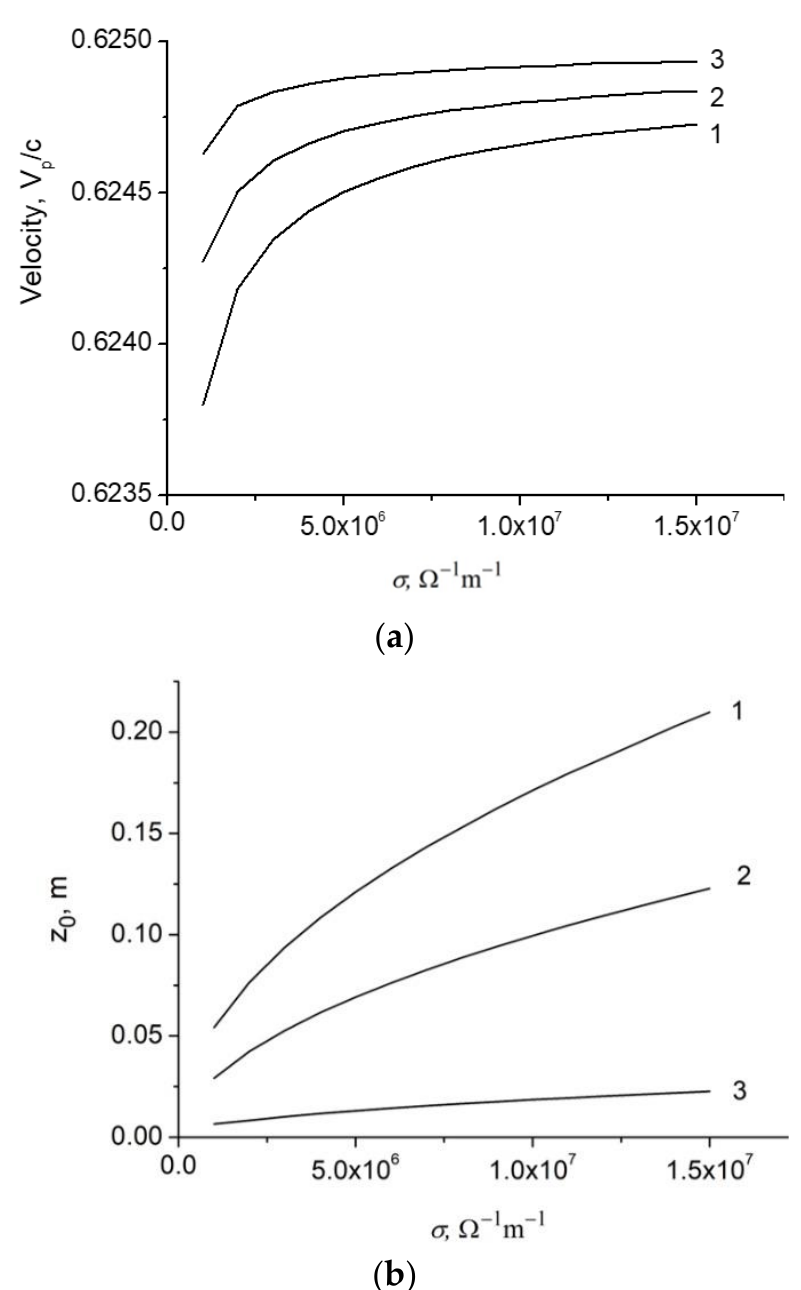
In Figure 8, the velocities and attenuation lengths as a function of conductivity are presented for different frequencies of SPW.